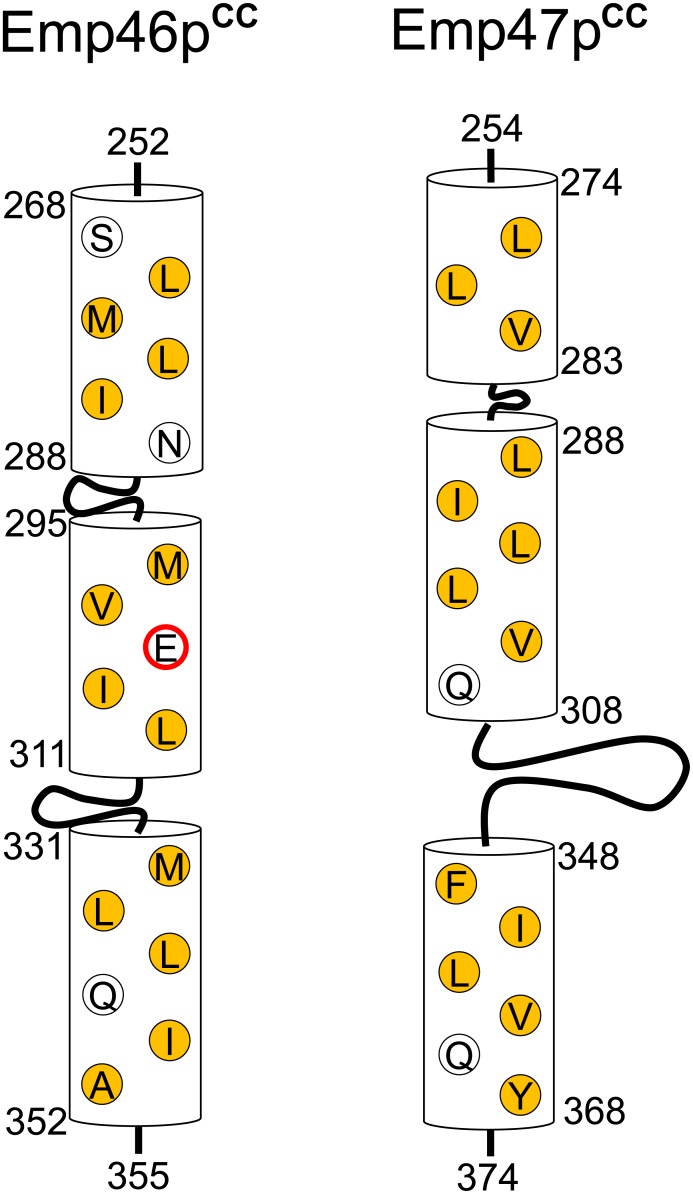
Schematic of the coiled-coil segments of Emp46pCC and Emp47pCC.Residues consisting of a hydrophobic core are represented. Hydrophobic residues are represented by yellow, whereas Glu303 is represented with a red circle.